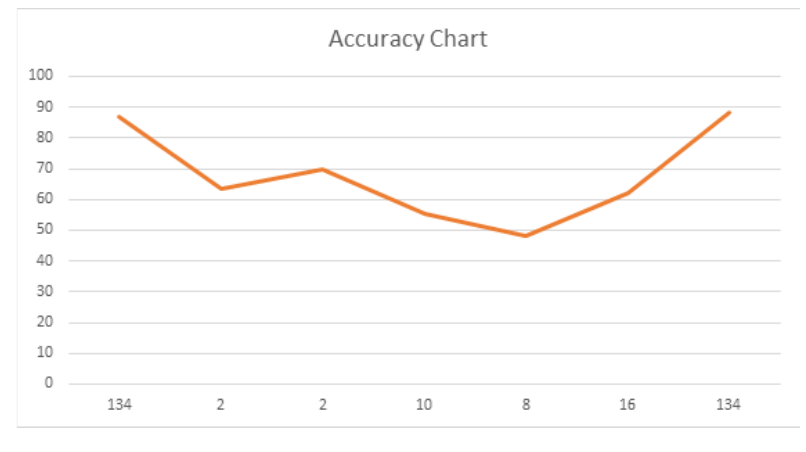
Figure 4. Proposed AD Prediction Results in Terms of Accuracy Value.